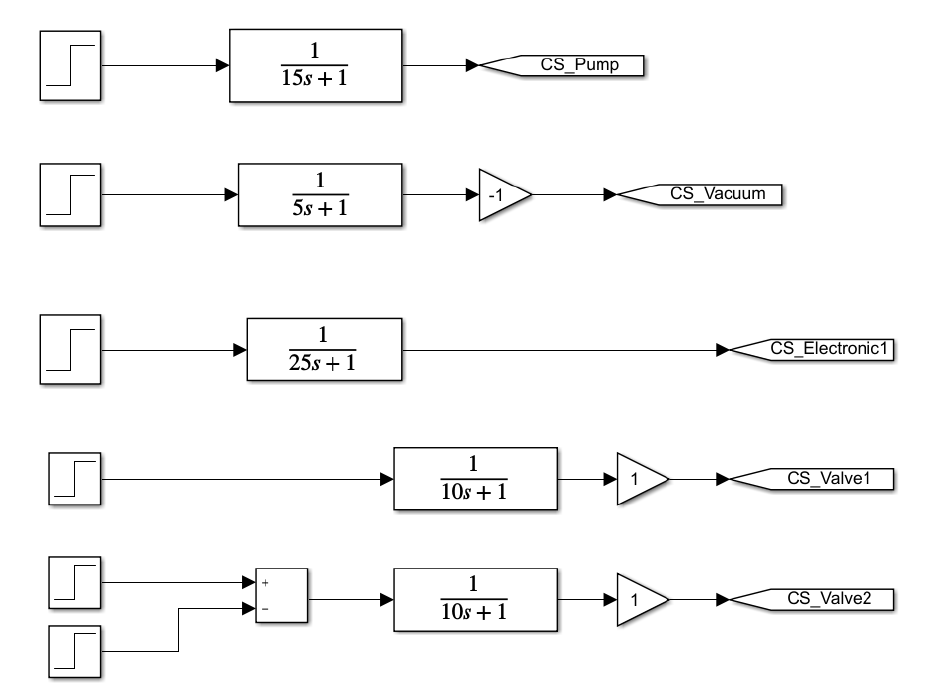
Figure 19. Control signals